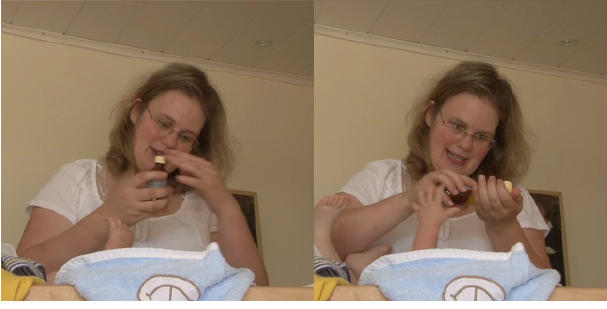
Figure 4. A mother announcing her next action that is performed on an object.